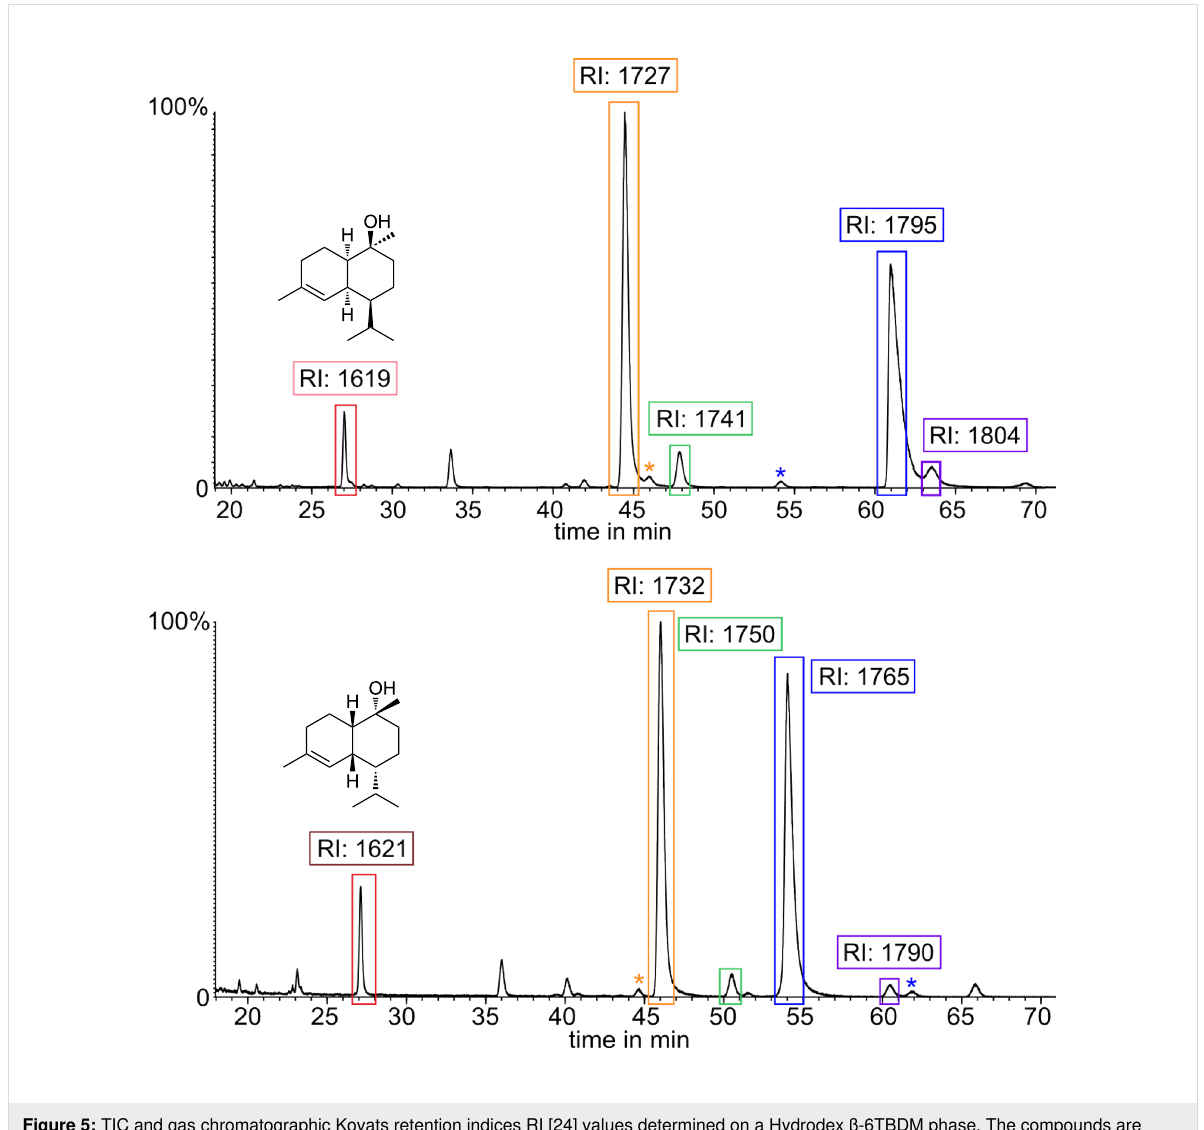
Figure 5: TIC and gas chromatographic Kovats retention indices RI [24] values determined on a Hydrodex β -6TBDM phase. The compounds are color-coded with the respective mass spectra in Figure 7 of each cadinol-type. Orange: δ -cadinol; blue: τ -cadinol; red: amorph-4-en-10 β -ol; violet: α -cadinol. Upper trace: (4 S )-diastereomers; lower trace: (4 R )-diastereomers. *Corresponding